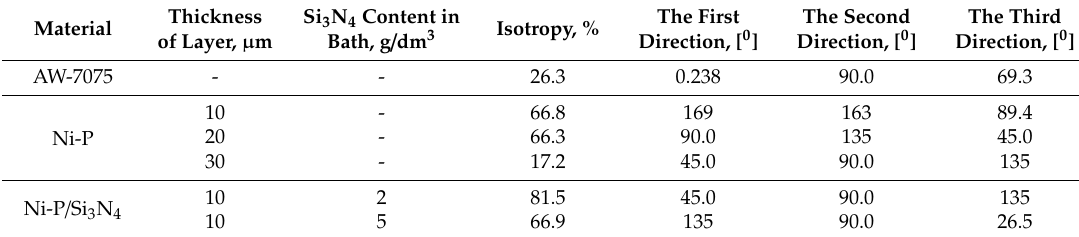
Table 6. Directions of surface